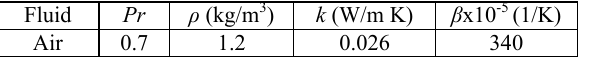
Table 1. Thermo-physical properties of working fluid